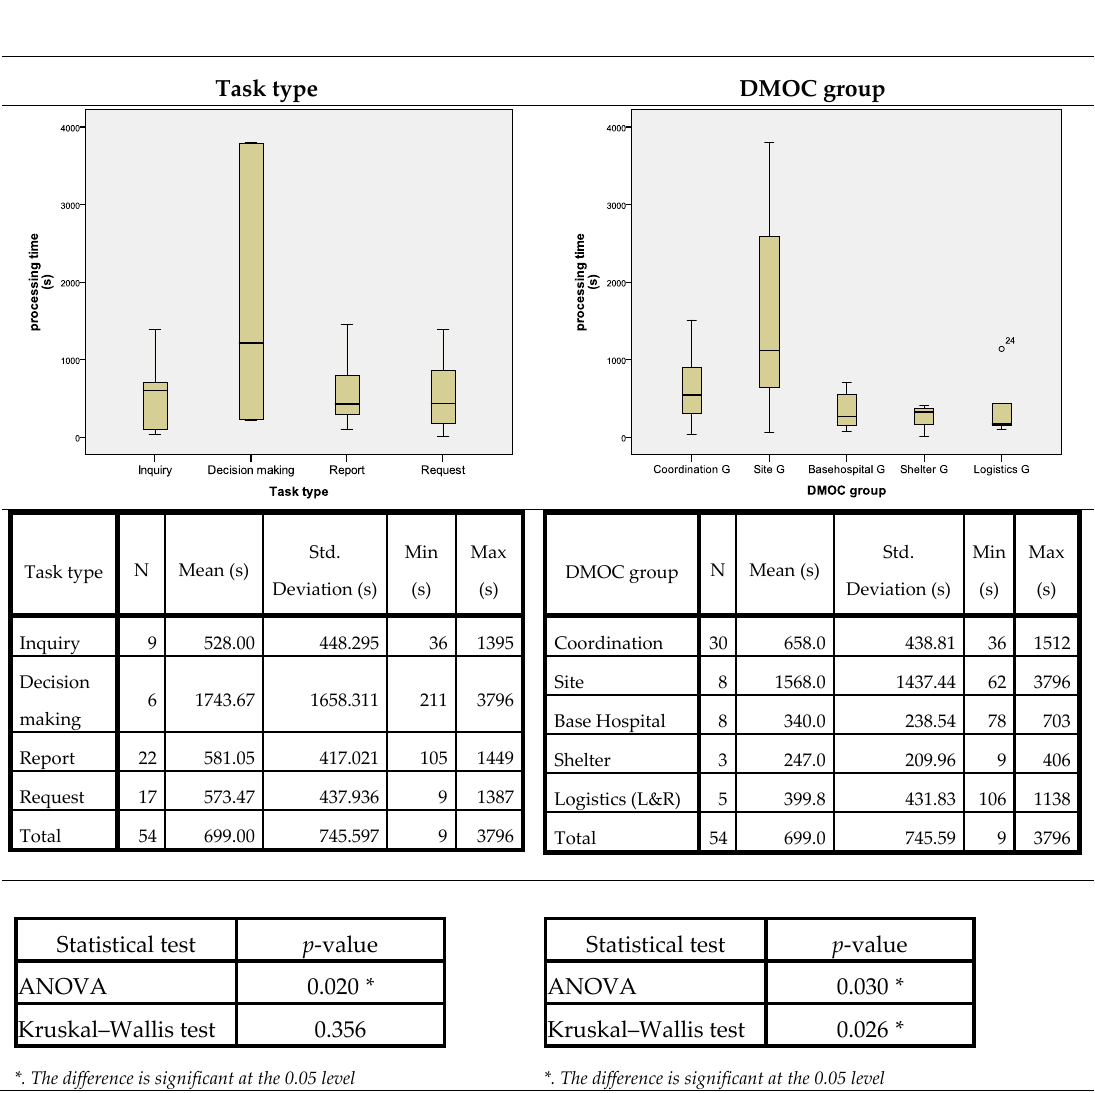
Figure 3. Task processing time across task types and DMOC groups in the October exercise.